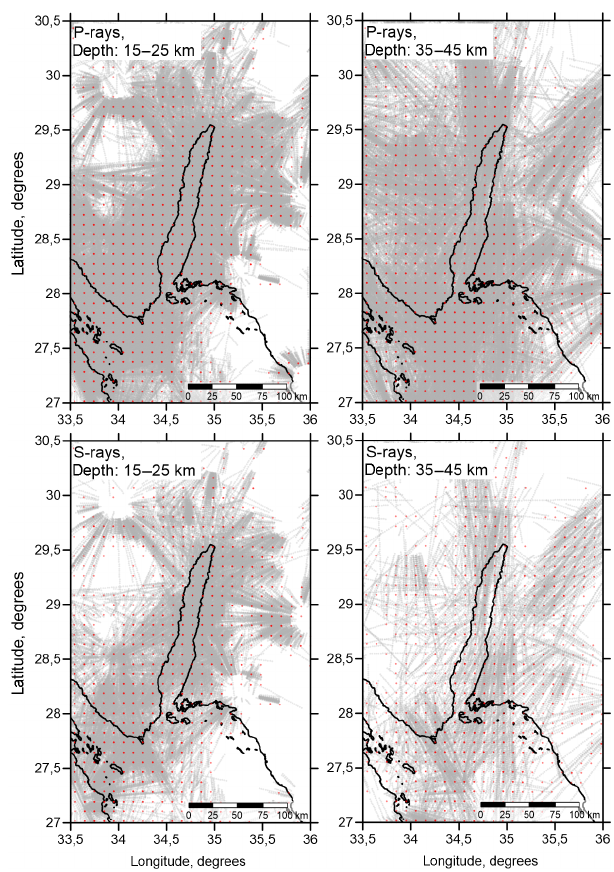
Figure 3. Distributions of the ray paths (gray dots) and nodes of the parameterization grid (red dots). Depth intervals and types of data are indicated on the top left of the maps. Table 1. Values of some parameters used to calculate the main to- mographic model.